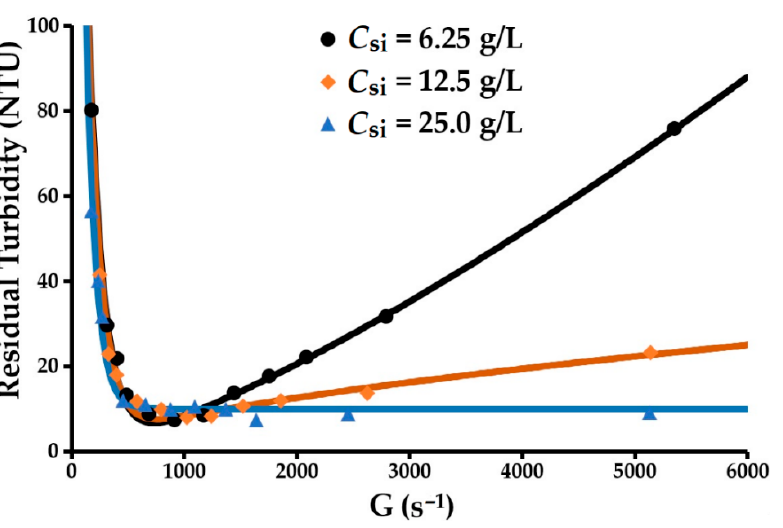
Figure 3. Modeling the variation of residual turbidity vs. velocity gradient.